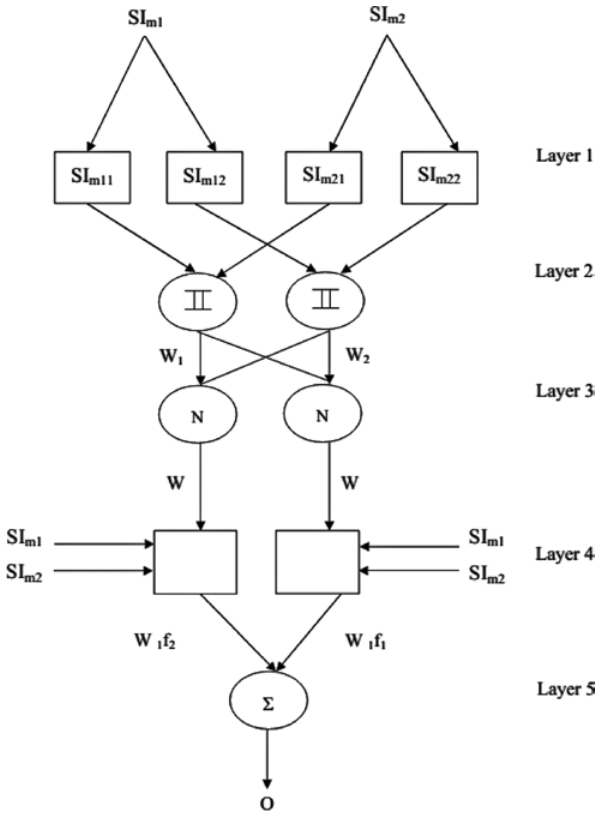
Figure 2: Structure for